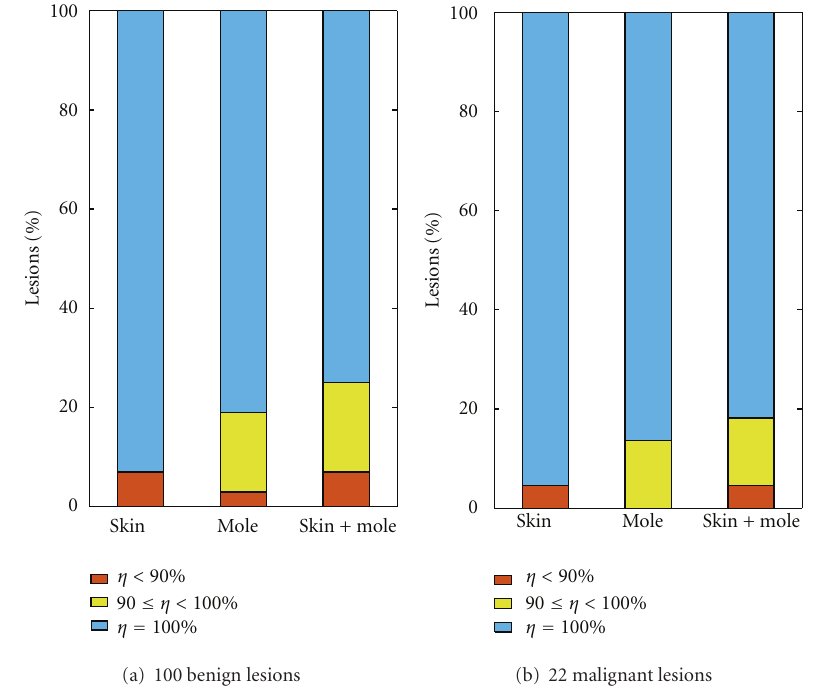
Figure 3: Average accuracy ( η ) of the detected seed regions for the images in the test set, according to the diagnosis. For visualization purposes, instead of the number of lesions, the vertical axis shows the corresponding percentage out of 100 benign and 22 malignant